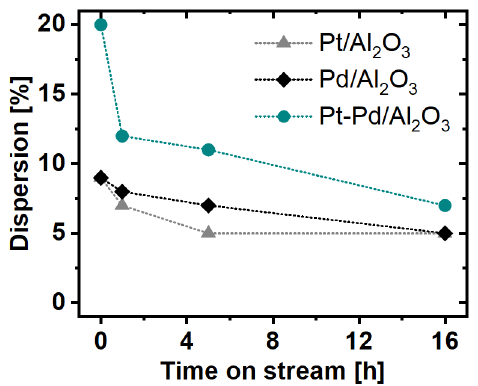
Figure 1. Noble metal dispersion obtained by CO chemisorption measurements during the course of hydrothermal aging. hydrothermal